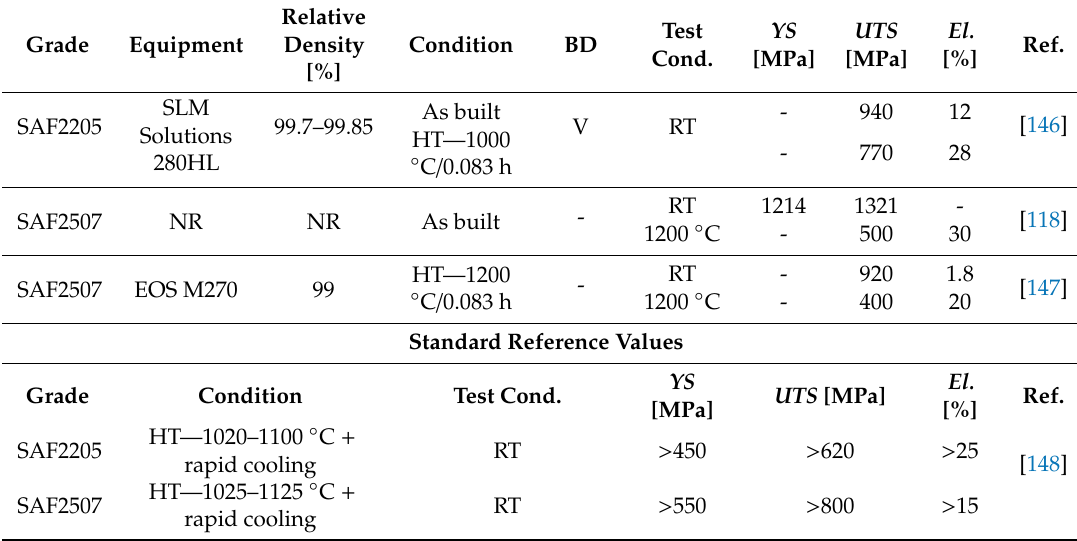
Table 6. Tensile strength of duplex stainless steel alloys obtained from L-PBF, compared to standard reference